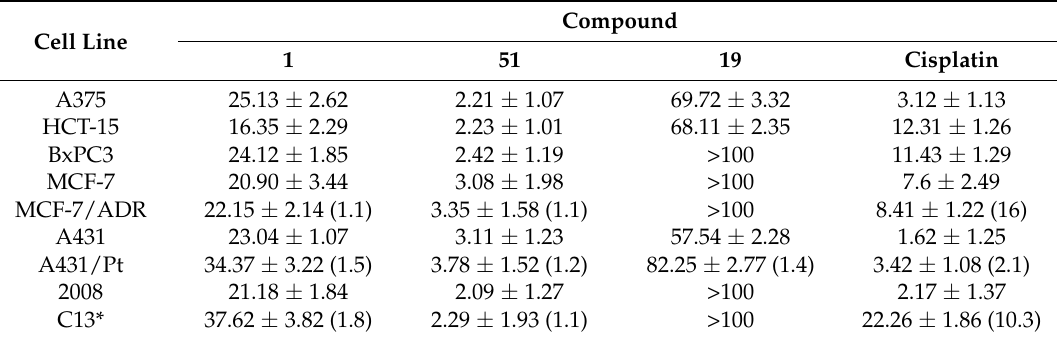
Table 9. Cytotoxicity of compound 51 compared to quercetin, 19 and cisplatin. 1,2,3